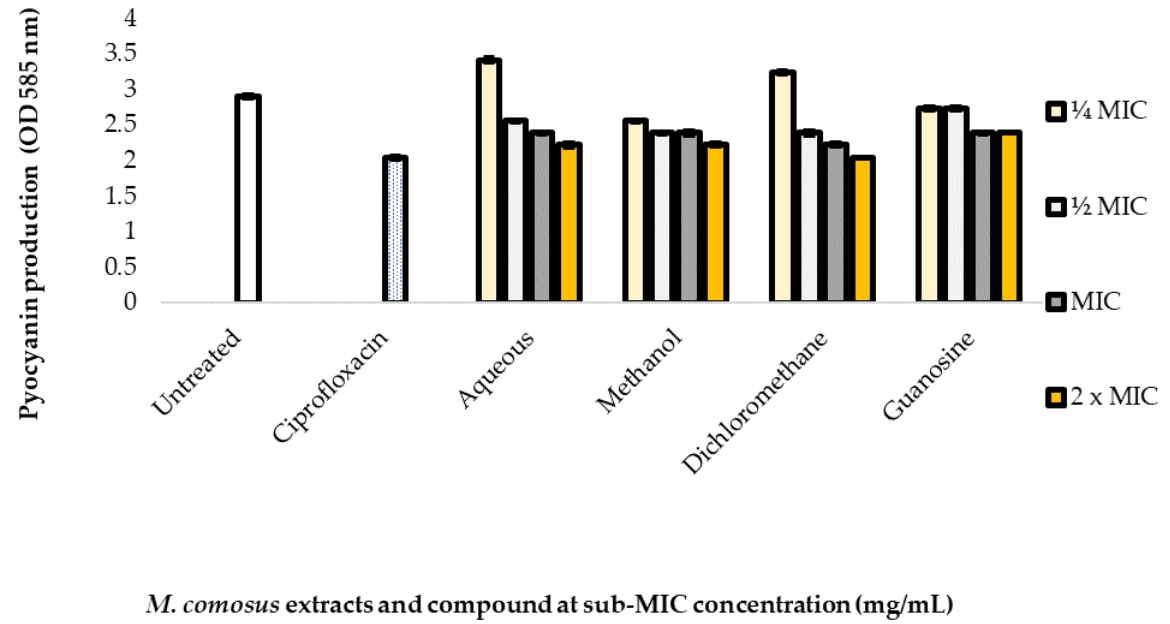
Figure 5. Pyocyanin production inhibition using Melianthus comosus (aqueous, methanol and dichloromethane) extracts and